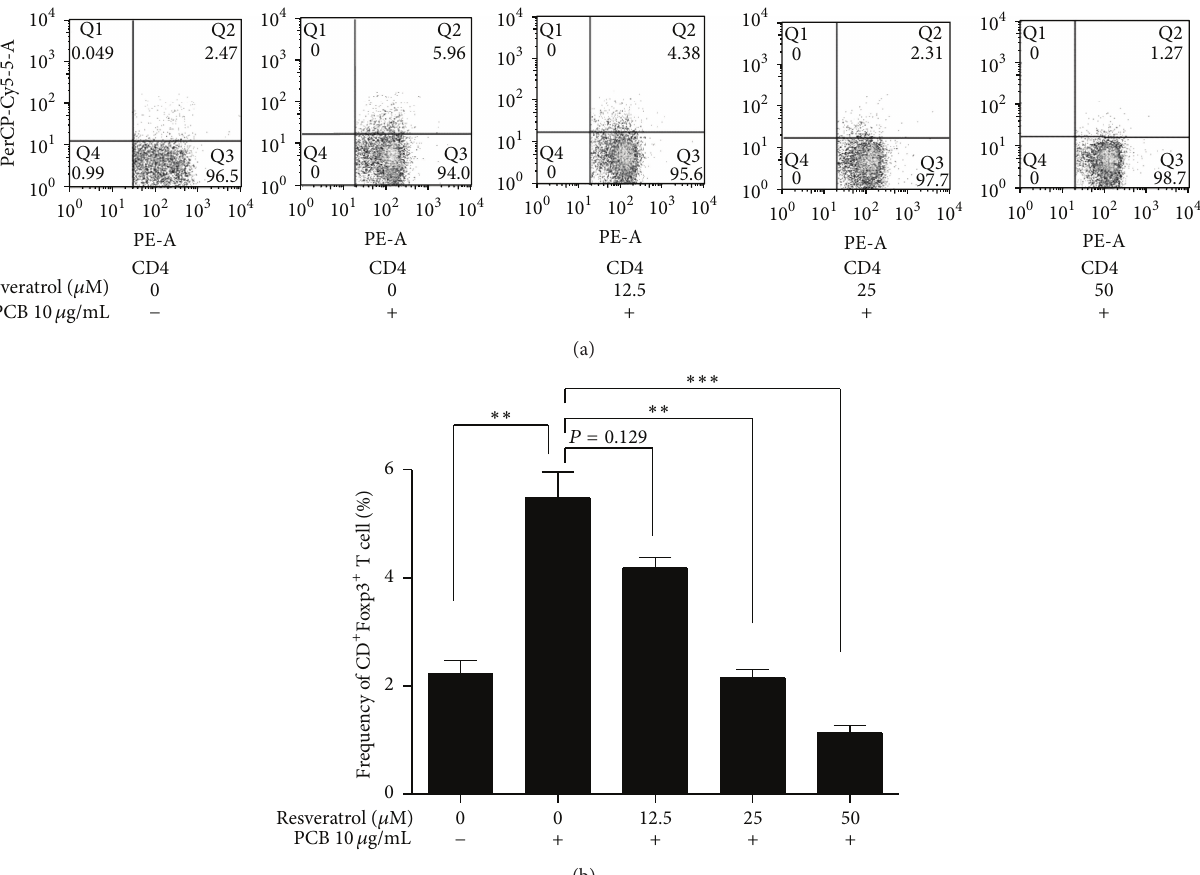
Figure 8: PCB extract induced the generation of inducible T regulatory cells via the aryl hydrocarbon receptor. (a) CD4 + CD62L + na¨ıve T cell from splenocytes and mLN cells from BALB/c mice were stimulated with anti-CD3 and anti-CD28 antibodies in the presence of 10 𝜇 g/mL PCB and the AhR antagonist resveratrol (12.5, 25, and 50 𝜇 M) for 72 h. Foxp3 + CD4 + T cell populations were then quantified using flow cytometry. (b) The plots show the mean population of Foxp3 + CD4 + T cells from three independent experiments. Data are presented as the mean ± standard deviation (SD) of triplicate determinations and were analyzed using one-way repeated measures of ANOVA followed by Dunnett’s post hoc test. ∗∗ 𝑃 < 0.01 and ∗∗∗ 𝑃 < 0.001 versus